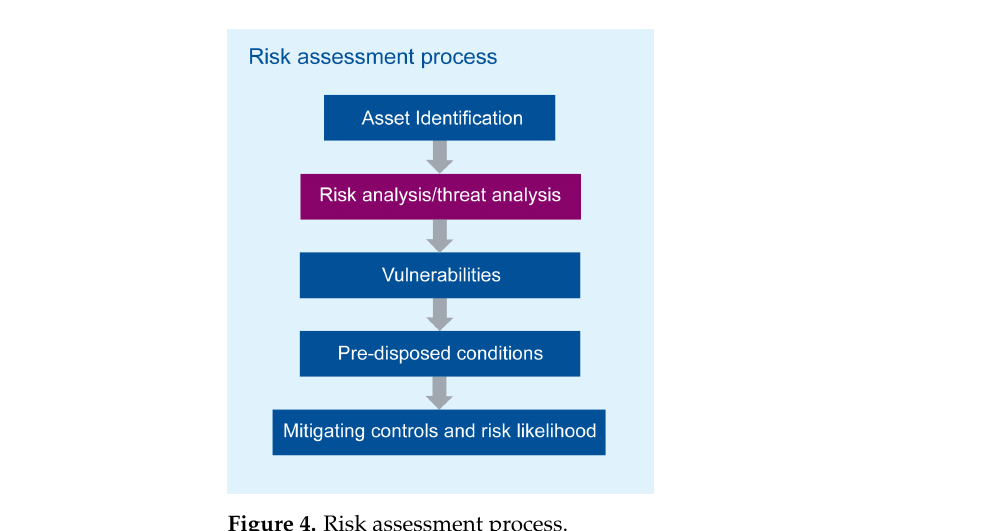
Figure 4. Risk assessment